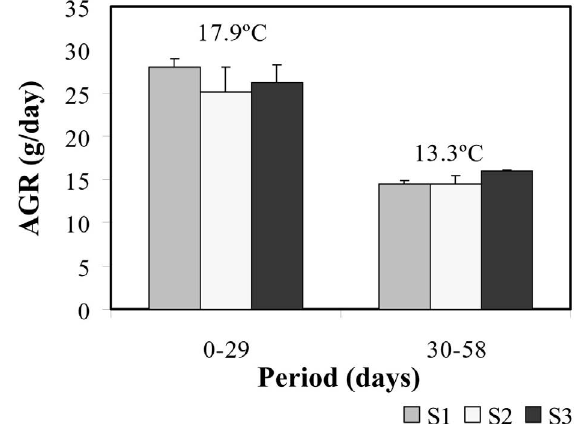
Fig . 4. – Mean values ± SD of absolute growth rate (AGR) and mean water temperature (ºC) for the periods comprised between